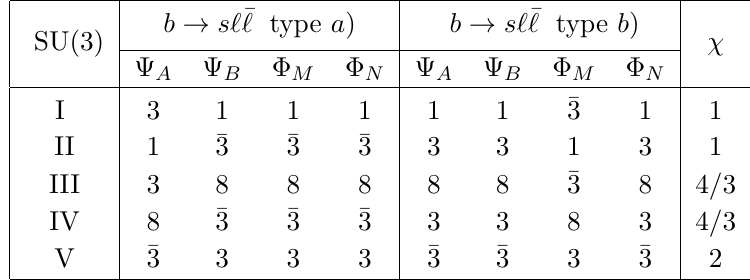
Table 1 . Table of the possible SU(3) representations that can give an e(cid:11)ect in b ! s‘ + ‘ (cid:0) or b ! s(cid:23)(cid:23) transitions via box diagrams. (cid:31) denotes the resulting group factor appearing in eqs. (2.4){(2.8) which also enters in b ! s(cid:23)(cid:23)